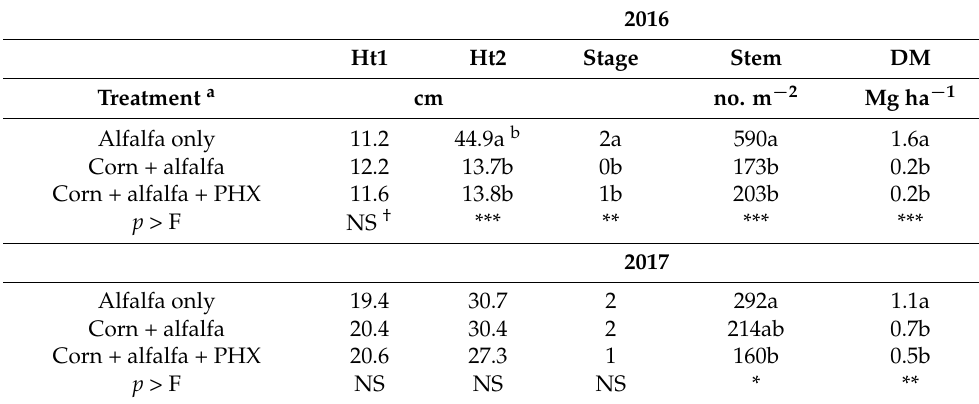
Table 7. Alfalfa plant height at V8 stage of corn (Ht1) and at harvest (Ht2); alfalfa growth stage (Stage), stem density (Stem), and dry biomass yield (DM) in seeding year of alfalfa in 2016 and 2017. 2016 Ht1 Ht2 Stage Stem DM Treatment a cm no. m − 2 Mg ha − 1 Alfalfa only 11.2 44.9a b 2a 590a 1.6a Corn + alfalfa 12.2 13.7b 0b 173b 0.2b Corn + alfalfa + PHX 11.6 13.8b 1b 203b 0.2b p > F NS † *** ** *** *** 2017 Alfalfa only 19.4 30.7 2 292a 1.1a Corn + alfalfa 20.4 30.4 2 214ab 0.7b Corn + alfalfa + PHX 20.6 27.3 1 160b 0.5b p > F NS NS NS